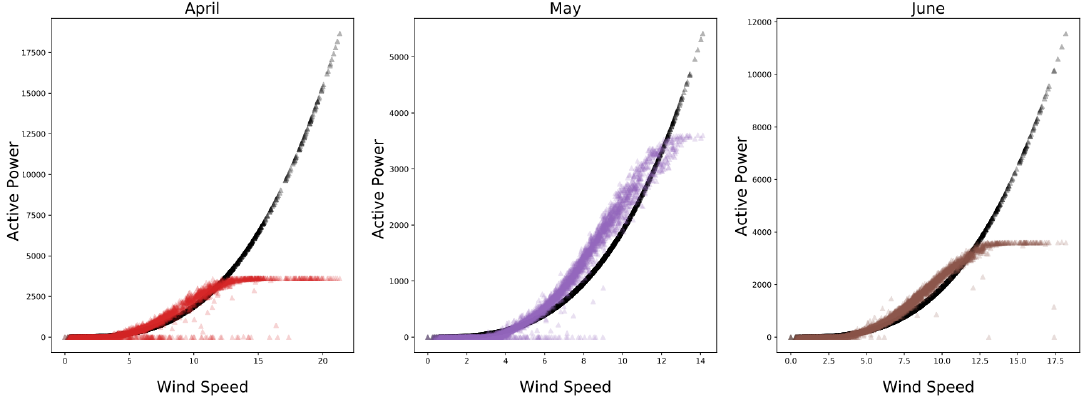
Figure 11. Wind energy generation in terms of active power, and theoretical